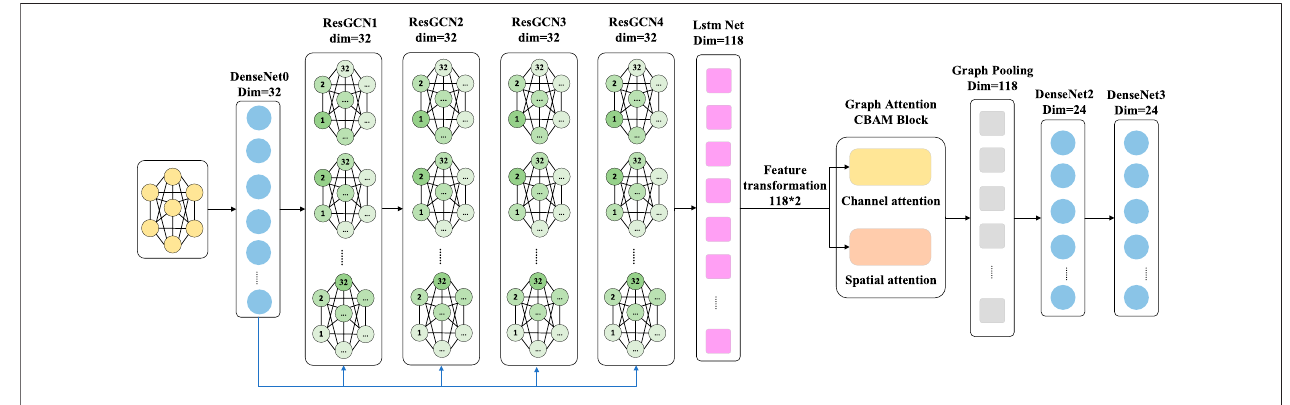
FIGURE 4 | Framework of ResGCN for short-term load